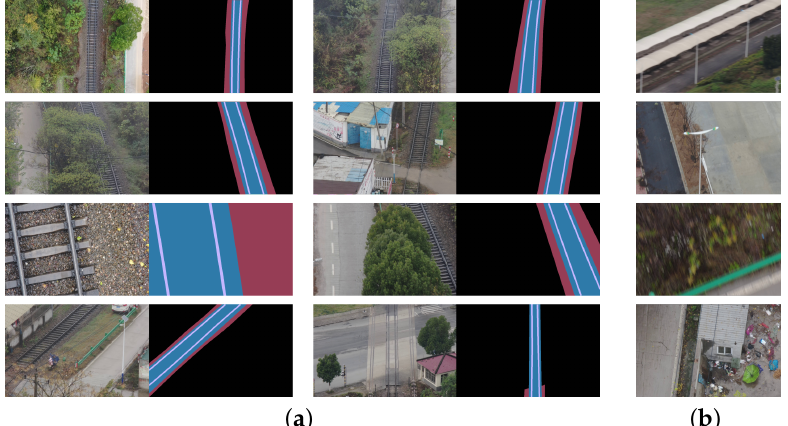
Figure 6. Railway line training samples from different scenes: ( a ) positive examples; ( b ) negative